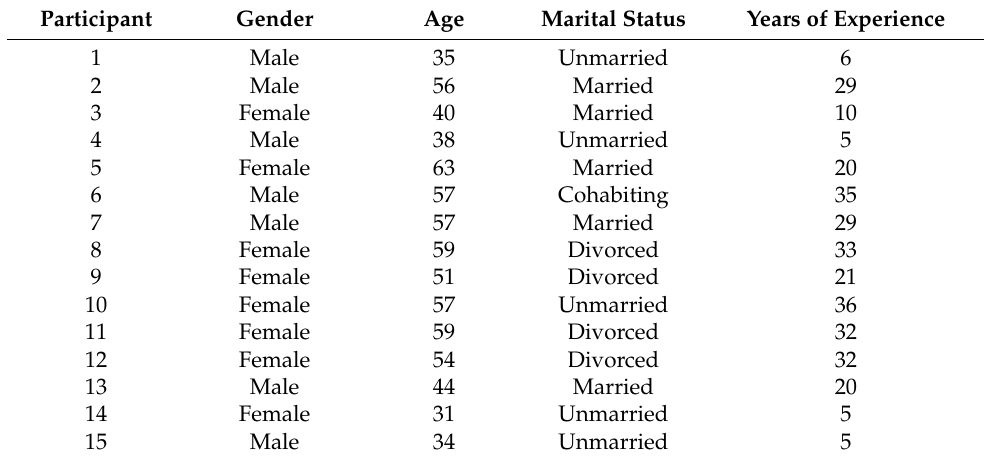
Table 1. Socio-demographic characteristics of participants.